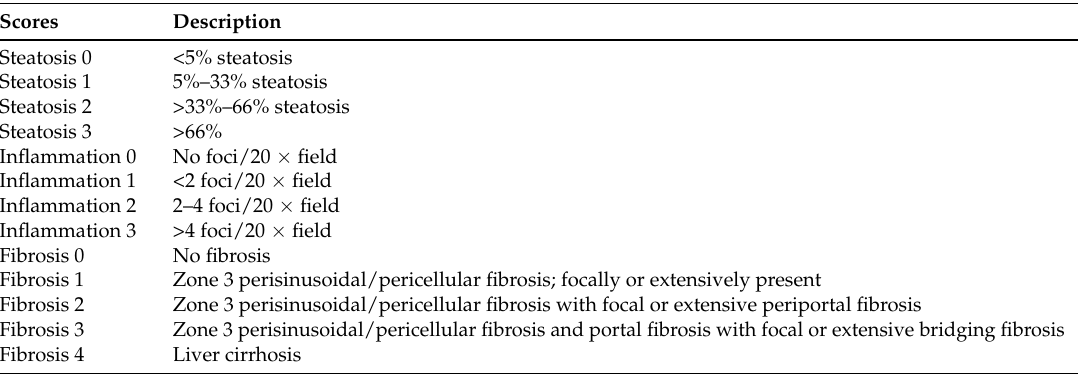
Table 2. Scoring of steatosis, inflammation and